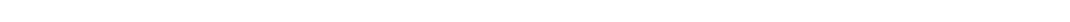
Fig. 5 Anti- fi brosis drug ef fi cacy under preventative treatment. a Overview of the strategy for preventative anti- fi brosis treatment and evaluation of the anti- fi brosis ef fi cacy based on the measurement of biomarker expression and tissue mechanical properties. Pirfenidone (Pirf.) and Nintedanib (Nint.) were co-administered with TGF- β 1 at the beginning of experiments and remained throughout the 6 day treatment period. b Representative immuno fl uorescence images of nuclei, α -SMA and pro-collagen of microtissues at day 6, with or without preventative anti- fi brosis treatments. Scale bar is 200 µ m. c Plot of tissue-level fl uorescence intensity of α -SMA and pro-collagen at day 6. d Time-lapsed measurement of microtissue contractile force. e Representative fl uorescent images of collagen type-I of TGF- β 1-treated and Pirf.-treated long microtissues. Zoom-in views showed that dilation of opening was inhibited by Pirf. treatment. Scale bar is 500 µ m. f Time-lapsed plot of the percentage microtissue area occupied by the tissue openings. Pirfenidone treatment almost completely inhibited opening dilation at day 6. g Plot of the microtissue stiffness measured by tensile test at day 6. h Plot of the microtissue compliance measured at day 6. Data are reported as the mean ± SD. n ≥ 10; * P < 0.05 when compared to TGF- β 1-treated condition; ** P < 0.001 when compared to TGF- β 1-treated condition. Statistical signi fi cance was determined by one-way ANOVA with Tukey